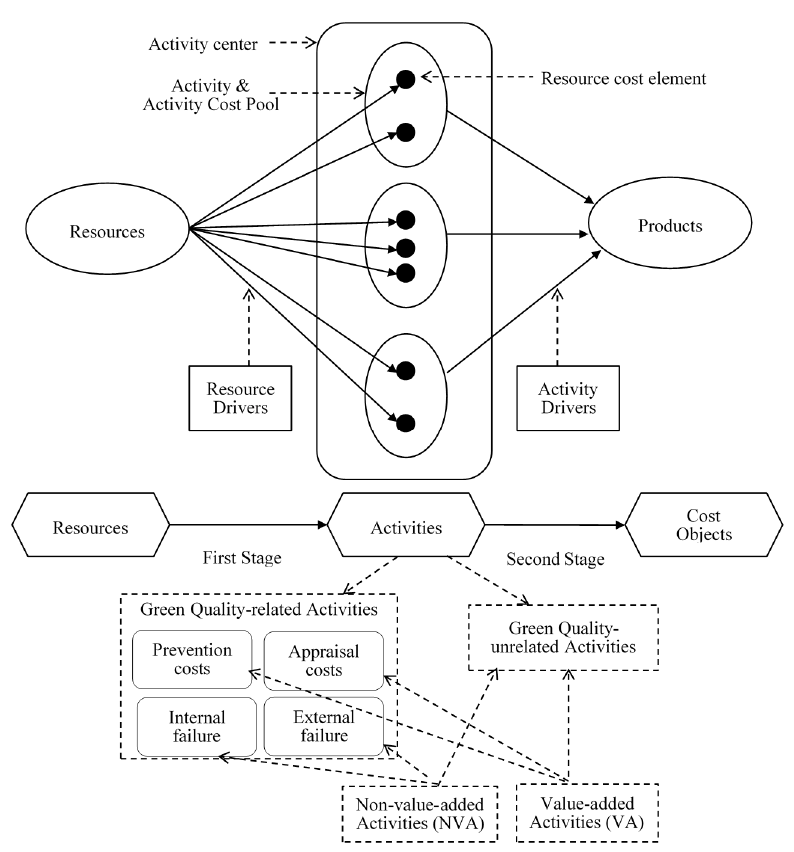
Figure 2. Cost Assignment of ABC’s two-stage model.